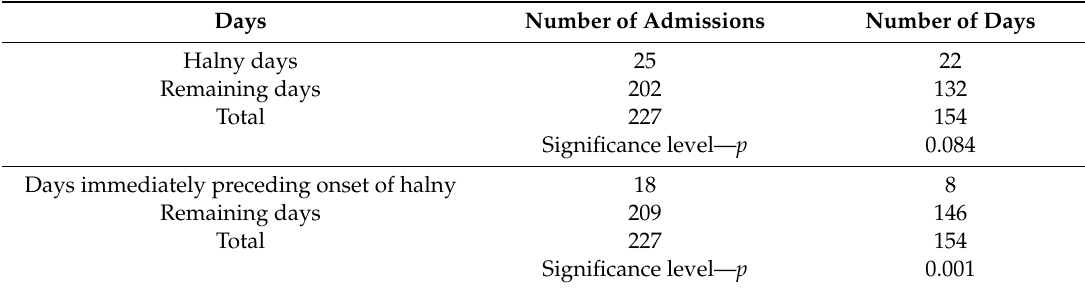
Table 5. Number of admissions on halny days, the remaining days during halny months and one day before onset of halny, and on the remaining days of months with